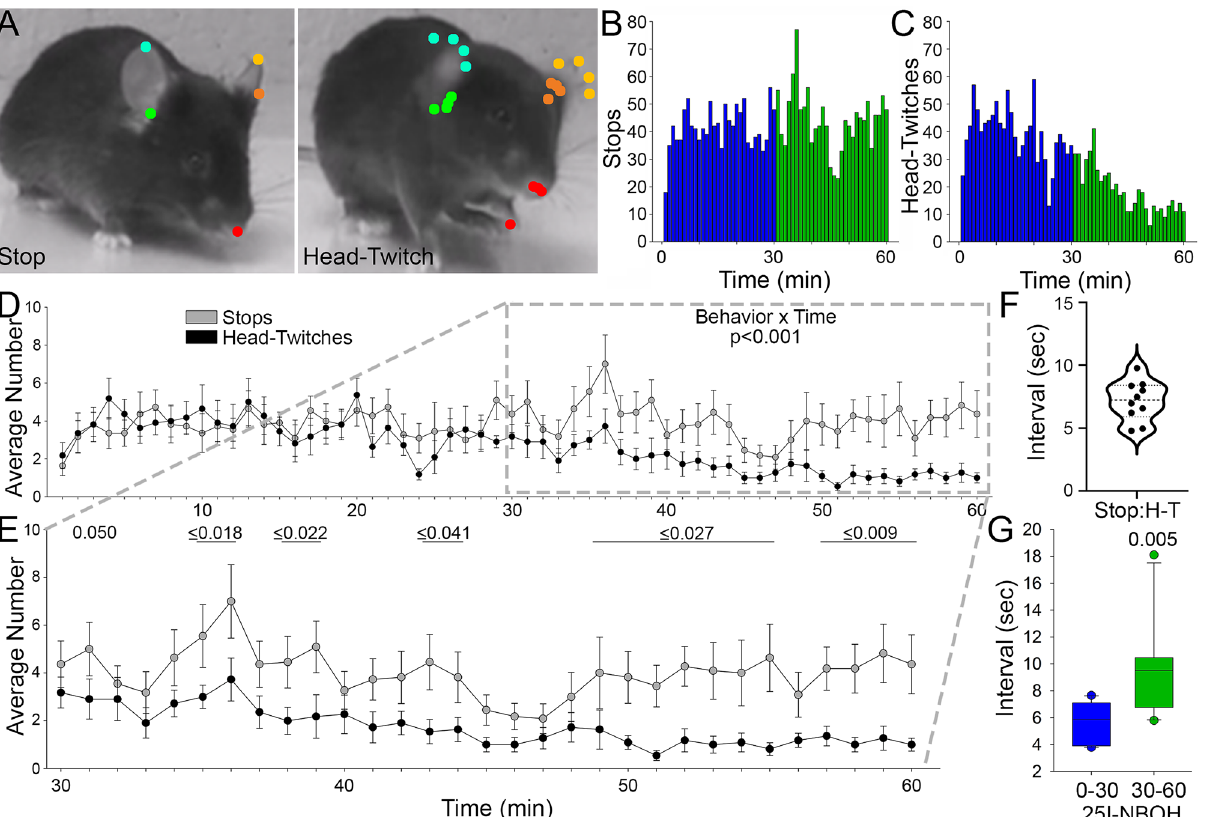
Figure 2. Behavioral arrest consistently precedes the head-twitch response following 25I-NBOH treatment. ( A ) Multi frame composites of a stop and head-twitch with points tracking movement during the distinct behaviors. ( B ) Frequency plot of cumulative stops during the 60 min testing period following 25I-NBOH treatment. ( C ) Frequency plot of cumulative head-twitches during the 60 min testing period following 25I-NBOH treatment. ( D ) Line plot of the average number of stops and head-twitches after 25I-NBOH. ( E ) Line plot highlighting the average number of stops and head-twitches during the last 30 min of the open field. ( F ) Violin plot showing the distribution of the average time interval between a stop and successive head-twitch. ( G ) Box plot comparing the time interval between stop and head twitch pairs during 0–30 and 30–60 min of the open field. Details of the experimental design and statistical analyses, including numbers of animals, mean ± SE, main effects and p values, can be found in Sup. Table